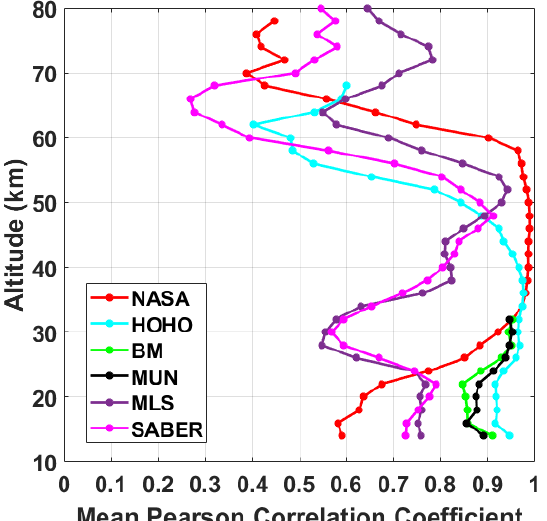
Figure 12. Vertical profiles of the correlation between temperatures reported by the various HOPS systems with respect to the HOH lidar temperature